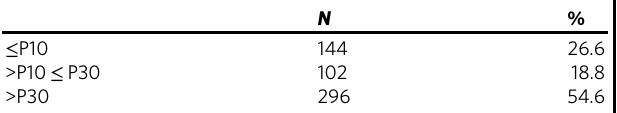
Table 2 Percentile distribution in T1 ( n =